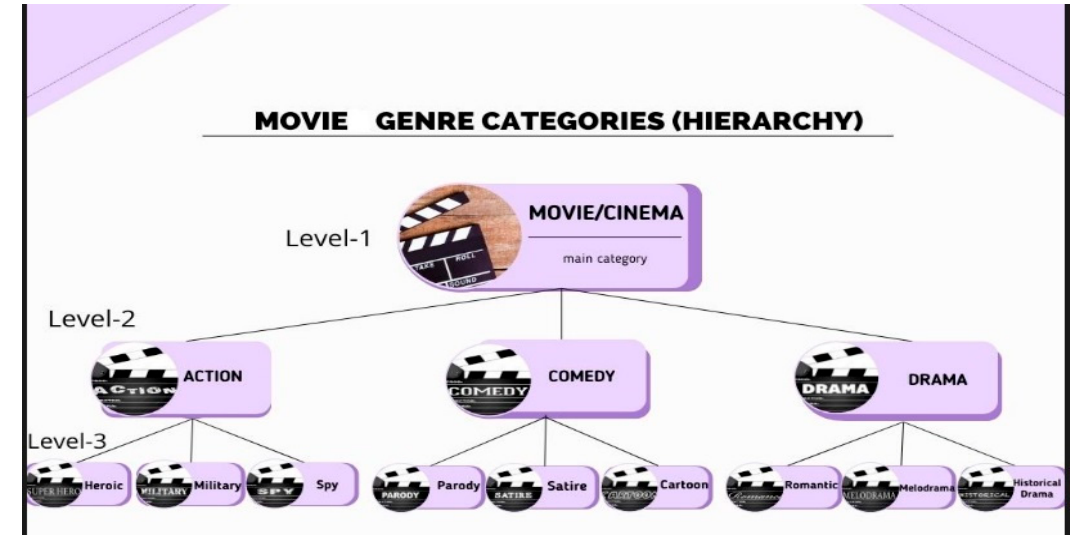
Figure 1. Movie categories.